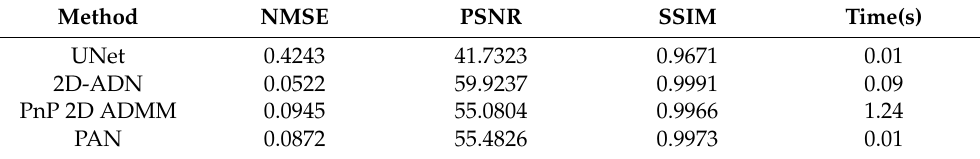
Table 3. Performance evaluation for the simulated 2D incomplete data under 15 dB condition.